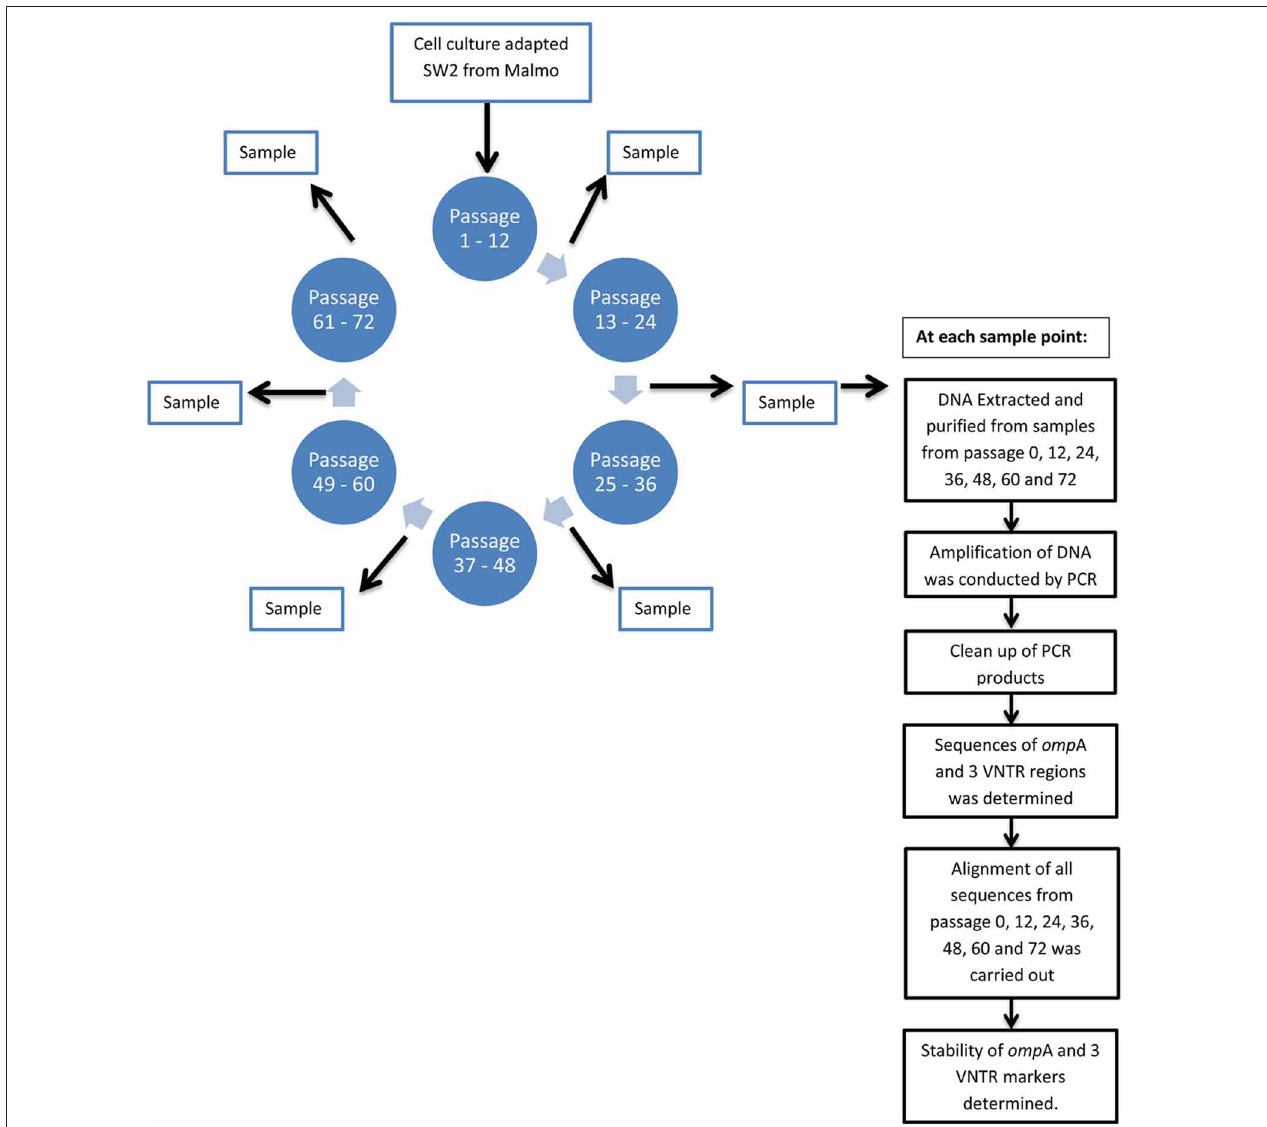
FIGURE 1 | Flow diagram showing the passage process of Sweden 2 and how the sample was processed to determine the stability of omp A and the VNTR